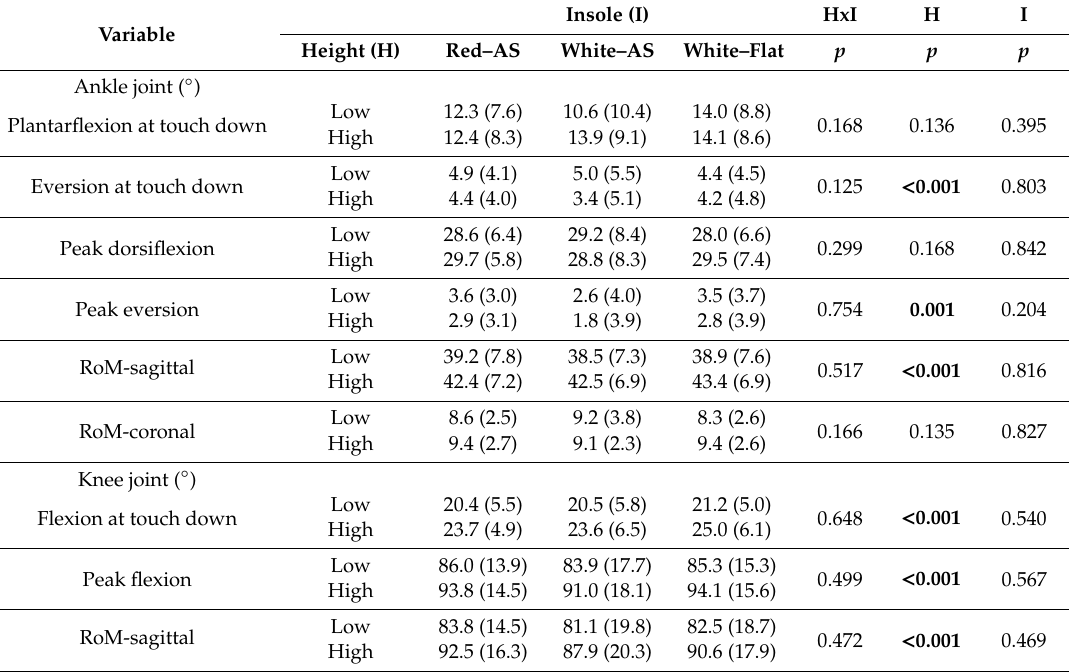
Table 1. Ankle and knee kinematics of three insole conditions during the two landing